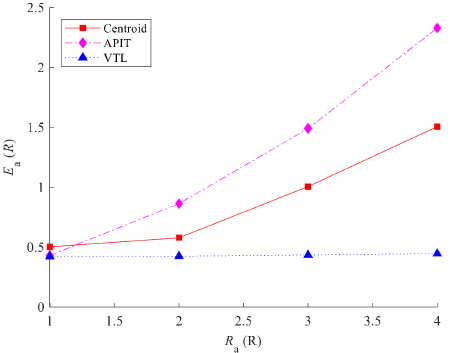
Figure 12. Radius of anchor nodes R a versus average estimation error E a (S = 200 × 200 m 2 , N t = 200, r a = 40%, R = 20 m, E GPS = 0, K =